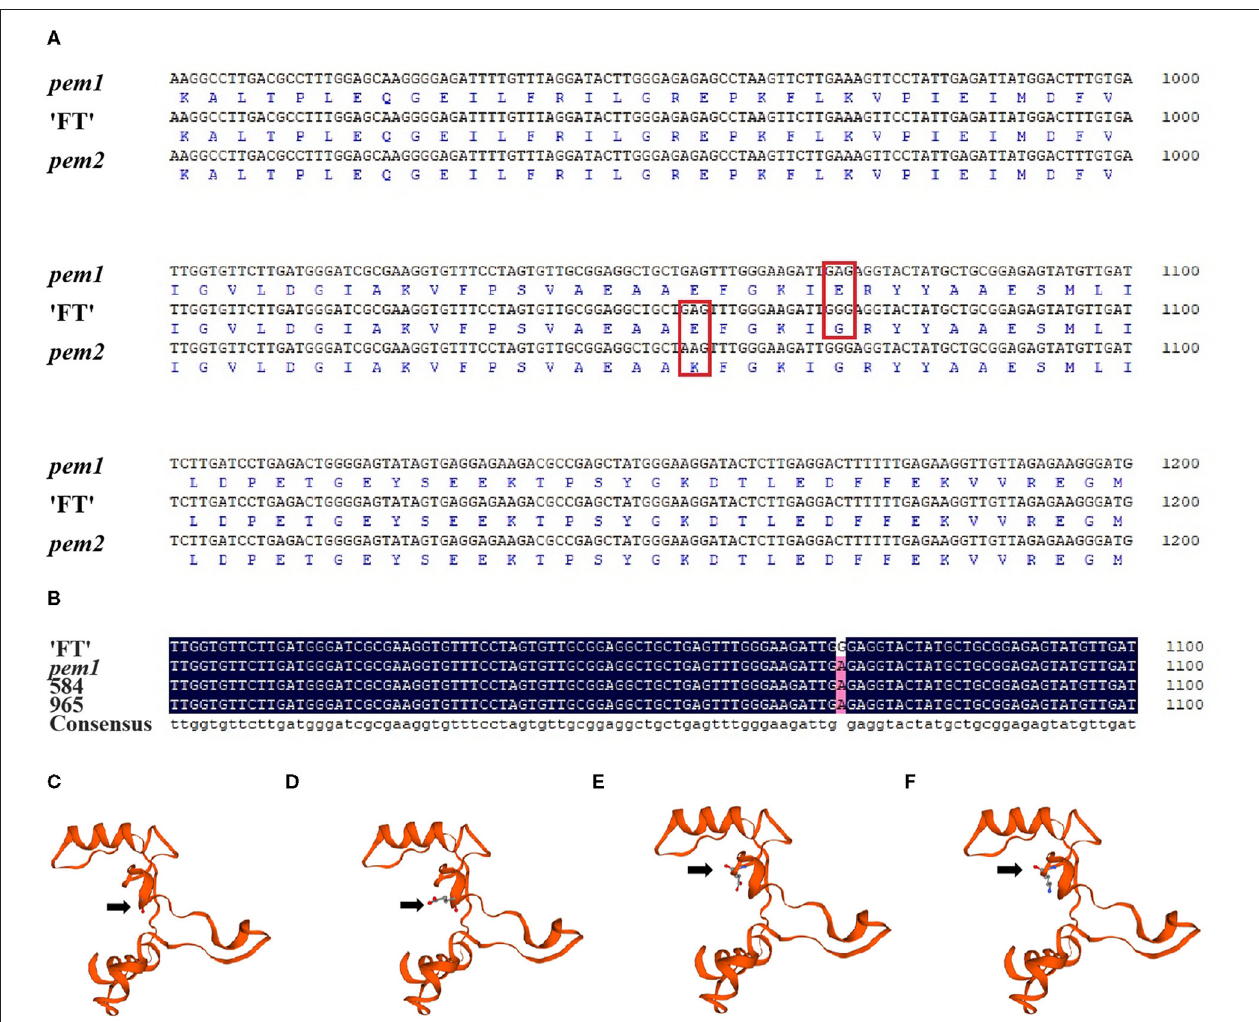
FIGURE 6 | Sequence alignments and three-dimensional structure of BraA10g021490.3C in pem1 and pem2 . (A) Alignments of the nucleotide and amino acid sequences of BraA10g021490.3C in pem1 and pem2 with “FT.” Red box, mutation site of pem1 and pem2 . (B) Alignment of the nucleotide sequences of BraA10g021490.3C in two F 2 -recombined individuals compared with “FT” and pem1 . “584” and “96” are the name of F 2 -recombined individuals. Three-dimensional structure of BraA10g021490.3C in “FT” (C) and pem1 (D) around the mutation site of pem1 comprises 90 amino acids. Arrows: amino acid 357 (Gly) of “FT” (C) and (Glu) of pem1 (D) . Three-dimensional structure of BraA10g021490.3C in “FT” (E) and pem2 (F) around the mutation site comprised 90 amino acids. Arrows: amino acid residue 352 (Glu) of “FT” (E) and (Lys) of pem2 (F) .